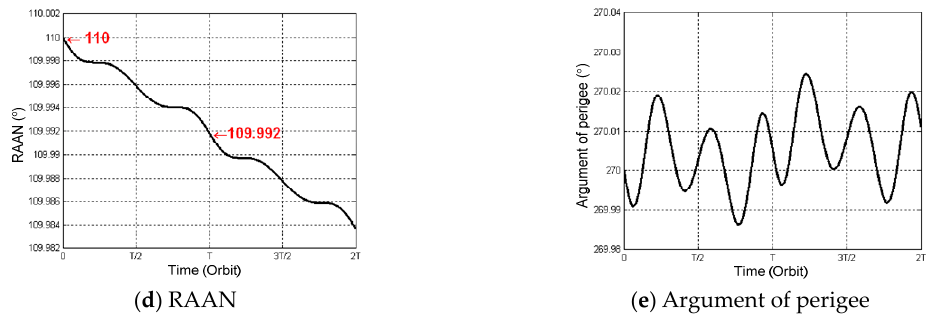
Figure 2. Curves of the short periodical terms of GEO SAR orbital elements’ variations under the influences of the J 2 term.